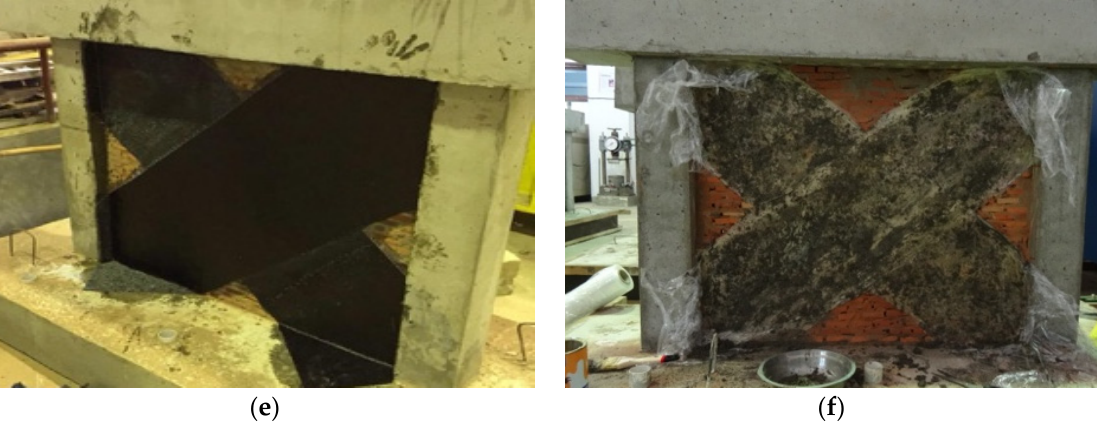
Figure 3. The RC frame with masonry infill specimens: ( a ) IFSW specimen, ( b ) IFSM–A specimen, ( c ) IFSM–P specimen, ( d ) IFSM–S specimen, ( e ) IFSM–FRP specimen, and ( f ) IFSM–PW specimen.